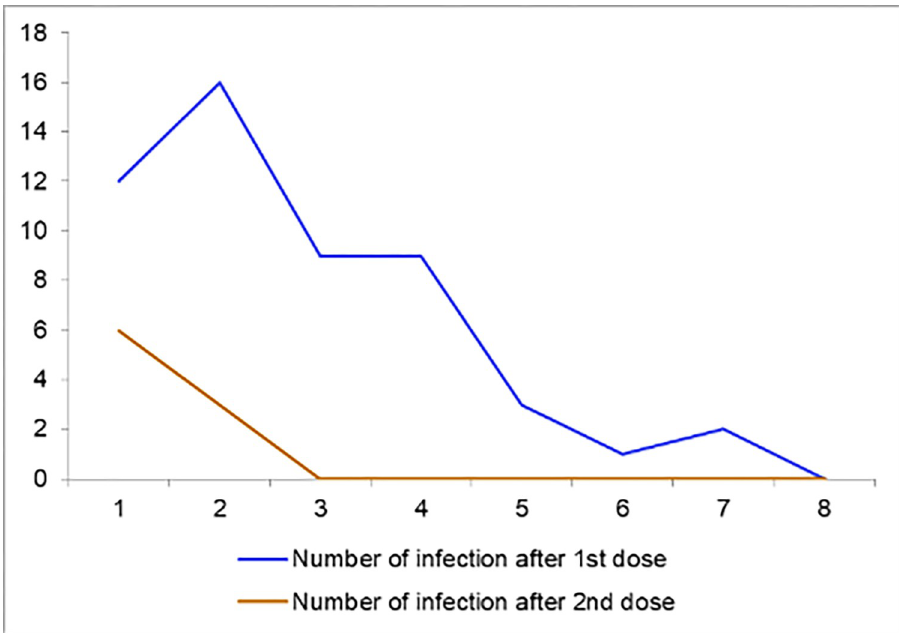
Fig 2. SARS-CoV-2 infection among the participants up to 8 weeks after vaccination (n = 61).